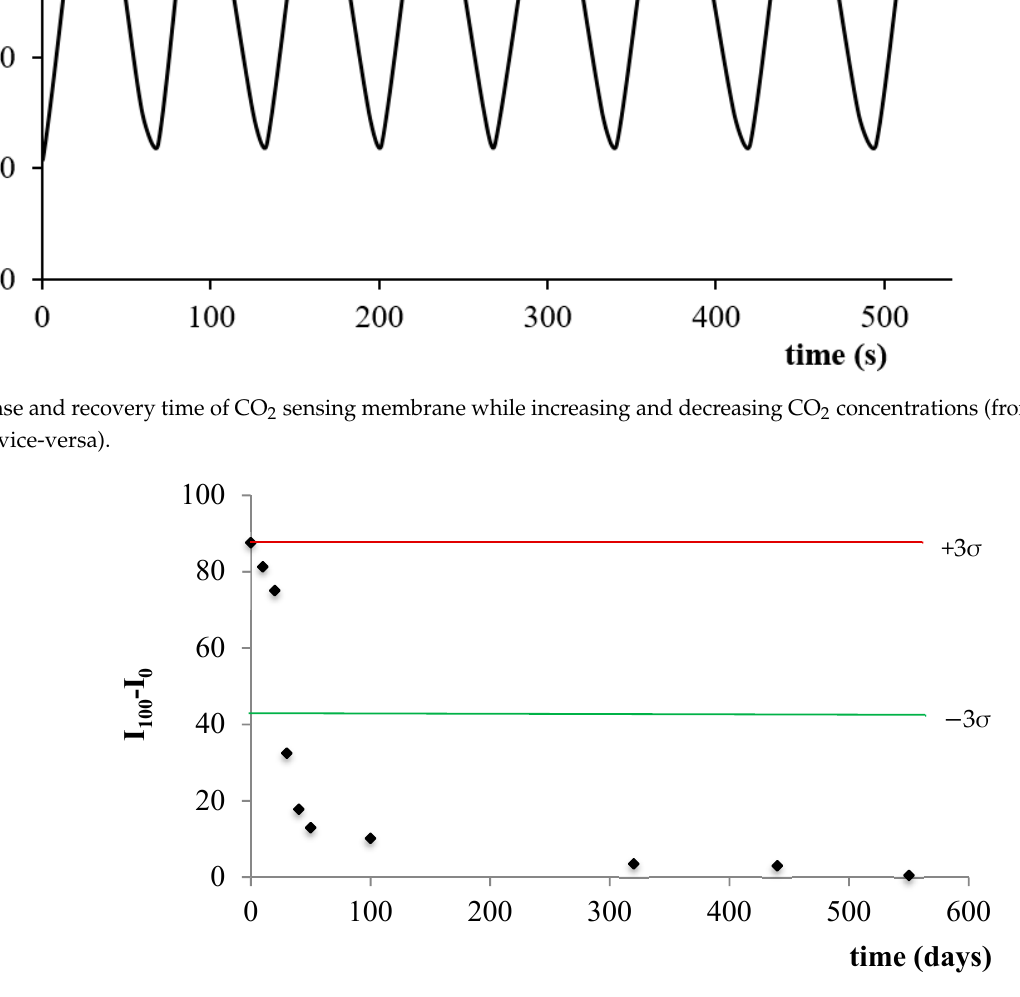
Figure 4. Response and recovery time of CO 2 sensing membrane while increasing and decreasing CO 2 concentrations (from 10% to 90% and vice-versa).